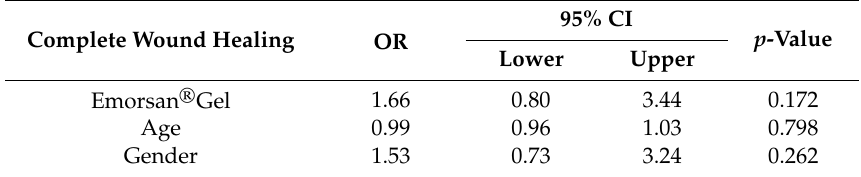
Table 3. Mixed-effects logistic regression exploring the likelihood of wound healing controlling for age and gender. 95% CI p -Value Complete Wound Healing OR Lower Upper Emorsan ® Gel 1.66 0.172 0.798 Gender 1.53 0.73 3.24 0.262 OR: odds ratio; CI: confidence interval.